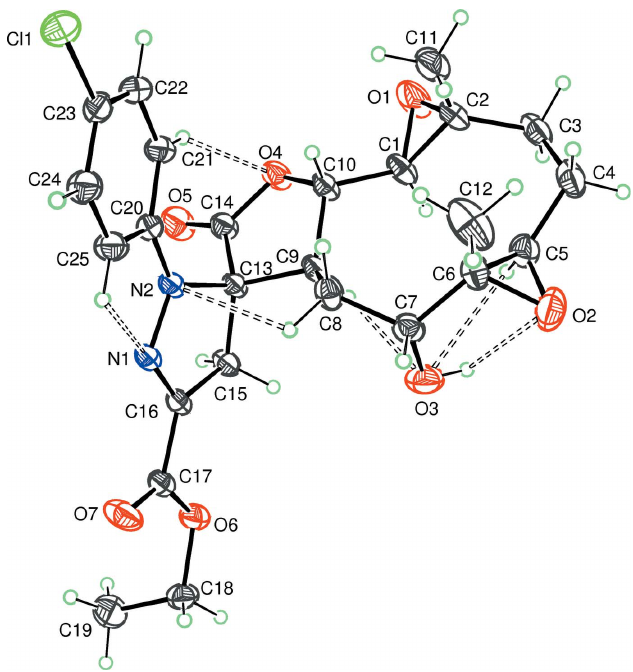
Figure 3 Crystal packing of the title compound showing the molecules stacked approximately along the b axis.